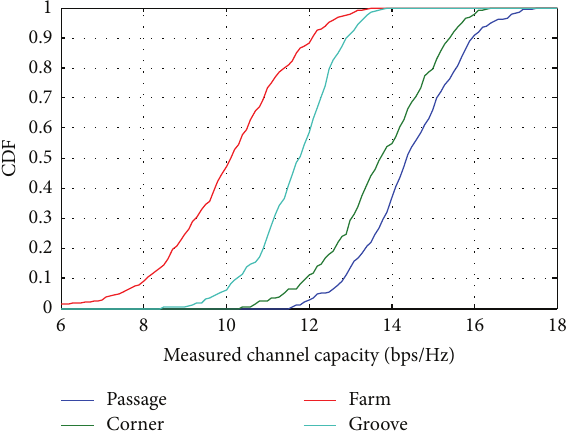
Figure 10: Distribution plot for spatial correlation coefficient.